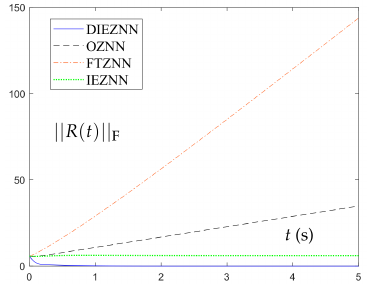
Figure 4. The error function norm (cid:107) R ( t ) (cid:107) F of the DIEZNN model (Equation (14)), OZNN model (Equation (5)), FTZNN model (Equation (8)) and IEZNN model (Equation (11)) for solving Equa- tion (1) under linear noise N ( t ) = 10 + 10 t . When the design parameters γ = 5, the error function norms (cid:107) R ( t ) (cid:107) F of the DIEZNN model (Equation (14)), OZNN model (Equation (5)), FTZNN model (Equation (8)) and IEZNN model (Equation (11)) are represented by blue solid curves, black dashed curves, orange dash-dotted curves and green dotted curves,